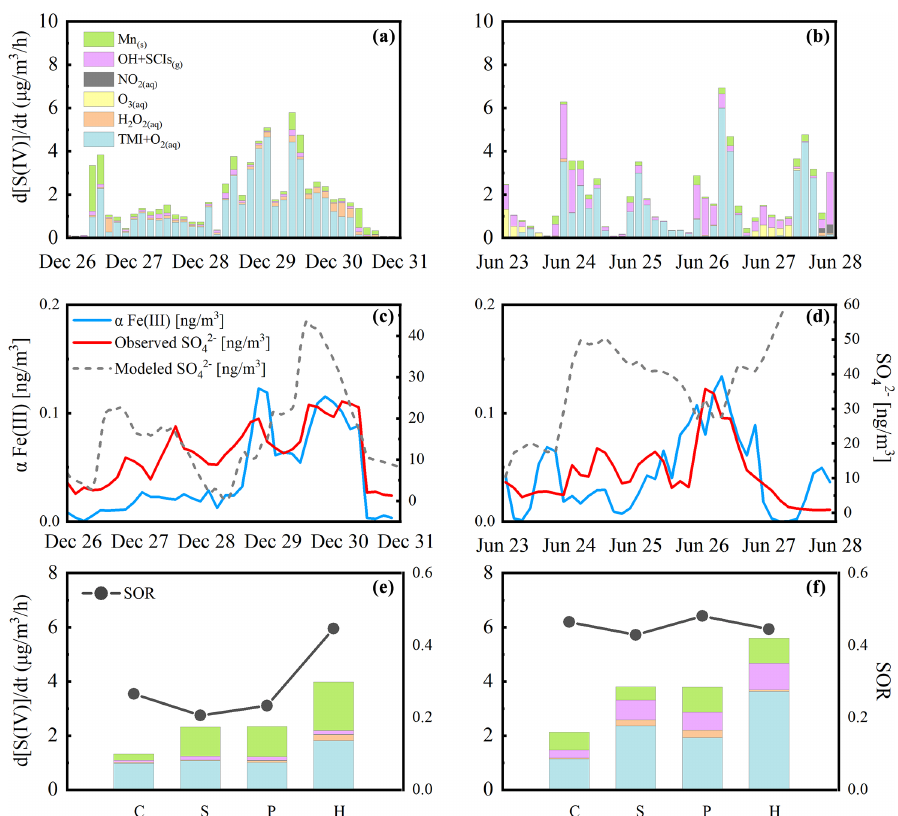
Figure 1. The 3h average sulfate formation rates during haze periods in winter and summer (a, b) . Corresponding effective Fe (III) con- centrations and sulfate concentrations (c, d) . Sulfate formation rates (the histogram) and the sulfate oxidation ratio (SOR; dotted lines) at different pollution levels in two field campaigns (e, f) . The contributions to sulfate formation from each multiphase oxidant pathway includ- ing Mn-surface oxidant (green), gas-phase OH radical and stabilized Criegee intermediate (SCI) oxidant (pink), aqueous-phase NO 2 (grey), O 3 (yellow), H 2 O 2 (orange), and the aqTMI (blue) are colored in the figure. Obvious particle growth and removal are observed in winter (26 to 31 December 2017), and diurnal variation patterns of sulfate concentration are observed in summer (23 to 28 June 2014). Diurnal trends of the modeled winter period’s sulfate concentration (dashed grey line) using deposition velocity at 1.5cm / s in winter and 2cm / s in summer are illustrated in panels (c) and (d) . The dotted lines in the (e) winter and (f) summer indicate the SOR with pollution levels across the whole of each campaign and the capitalized letters C, S, P and H are abbreviations for “clean”, “slightly polluted”, “polluted” and “highly polluted”,